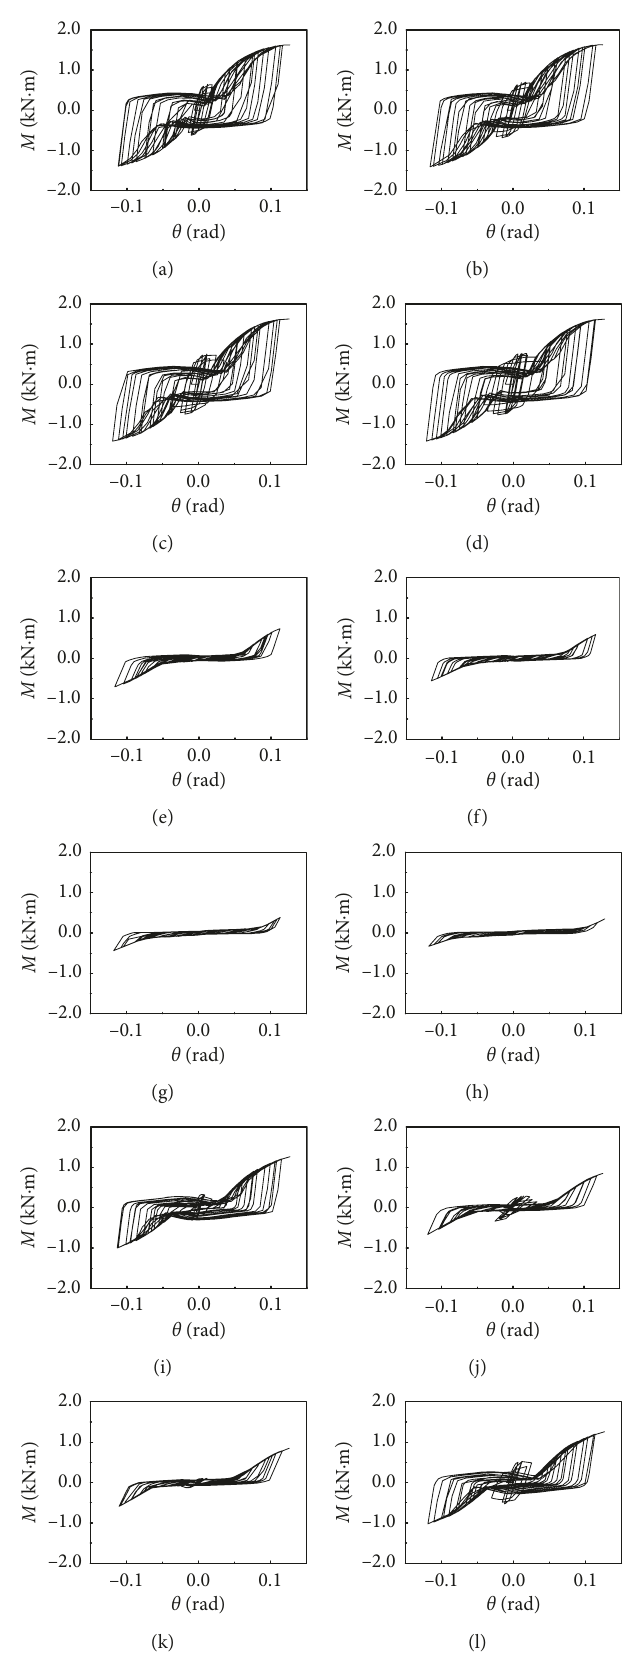
Figure 14: The (M- θ ) hysteresis curves for all damage models. (a) L1, (b) L2, (c) L3, (d) L4, (e) Q1, (f) Q2, (g) Q3, (h) Q4, (i) LQ1, (j) LQ2, (k) LQ3, and (l)